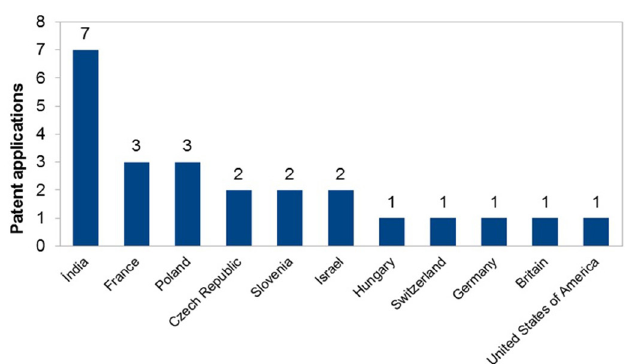
FIGURE 2 – Nationality of applicants in patent applications for clopidogrel crystalline forms.